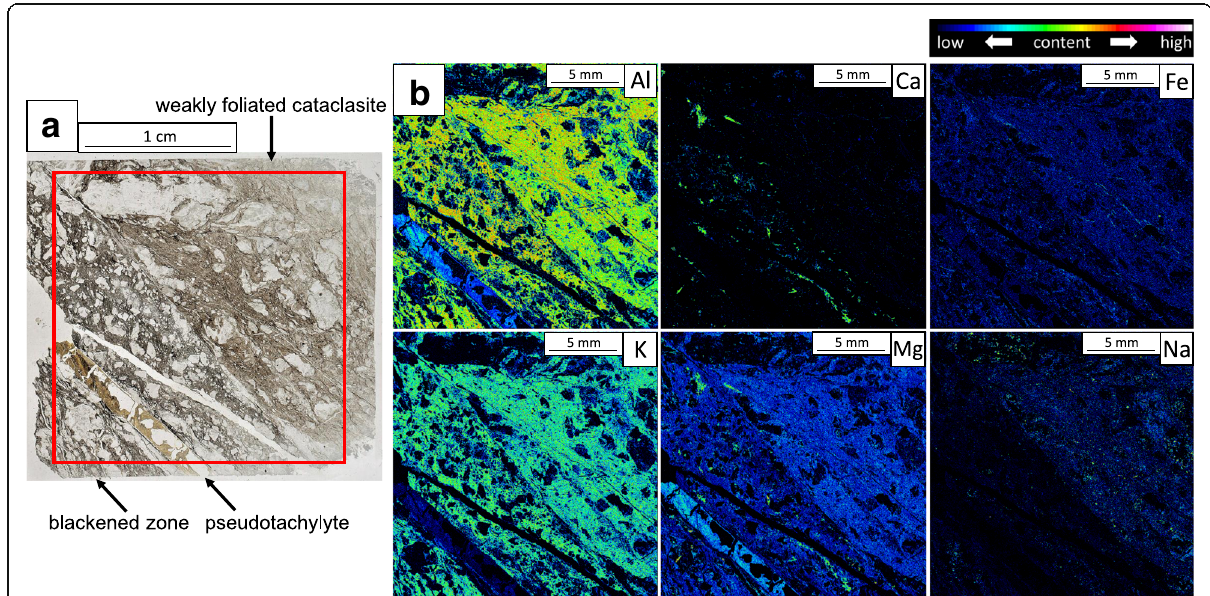
Fig. 4 The result of EPMA element mapping focused on pseudotachylyte, blackened zone, and foliated cataclasite. a An open-polarized photomicrograph of a thin section including pseudotachylyte, blackened zone and foliated cataclasite within PSZ. Red square represents the area of EPMA element mapping. b Result of EPMA element mapping (Al, Ca, Fe, K, Mg, Na). The color bar in the upper part shows concentration. In pseudotachylyte, only Mg is concentrated compared to blackened zone and foliated